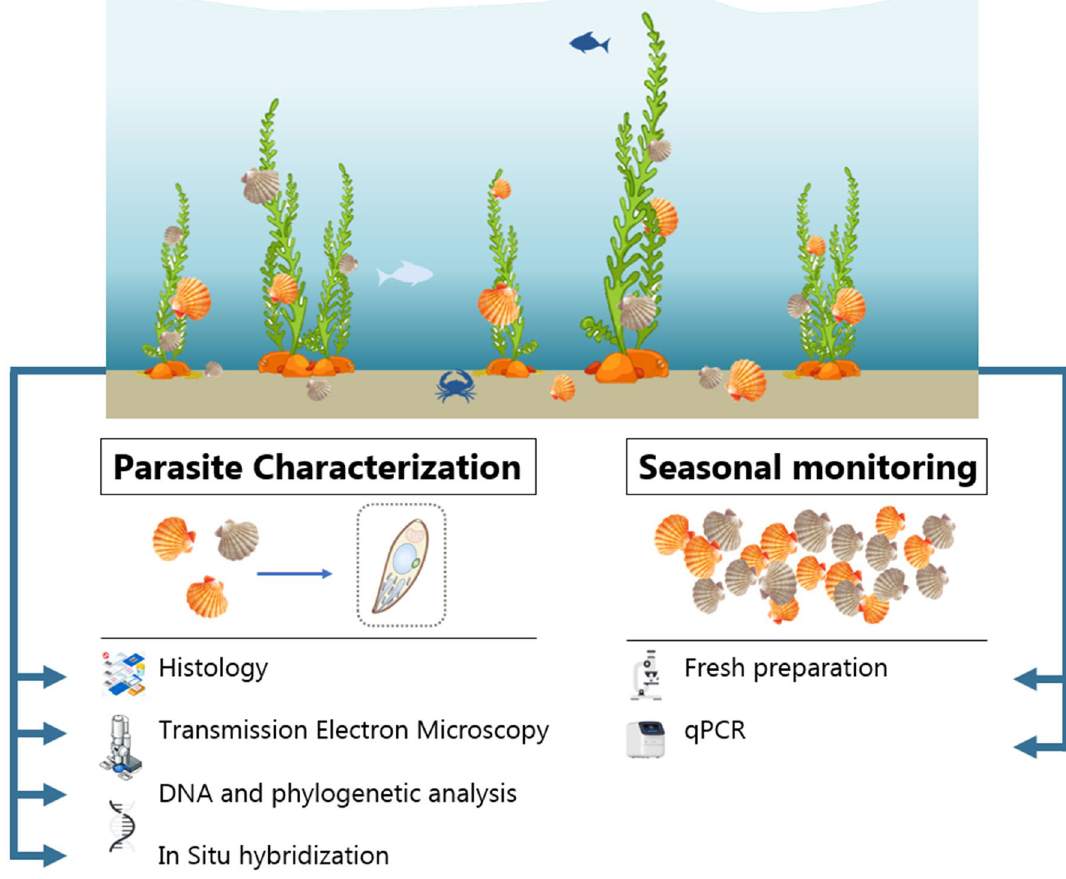
Figure 1. Schematic representation of the experimental workflow for parasite (Bay Scallop Marosporida) characterization and seasonal monitoring.